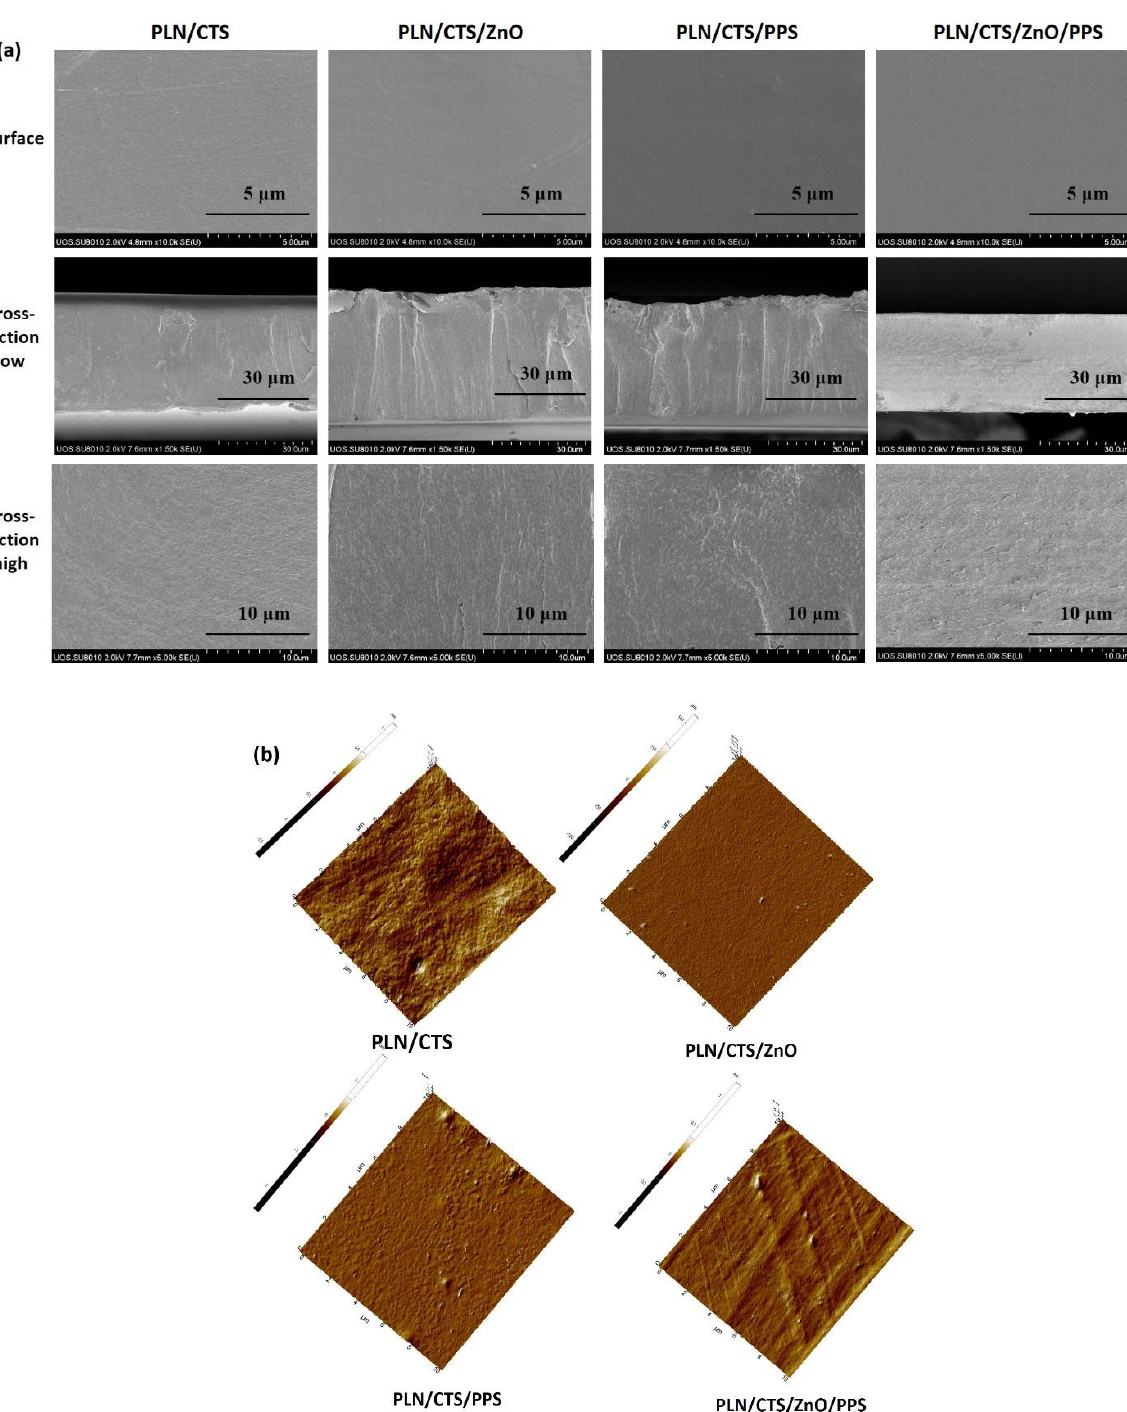
Figure 4. FESEM surface and cross-section micrographs ( a ) and AFM images ( b ) of pullulan/chitosan-based composite films.